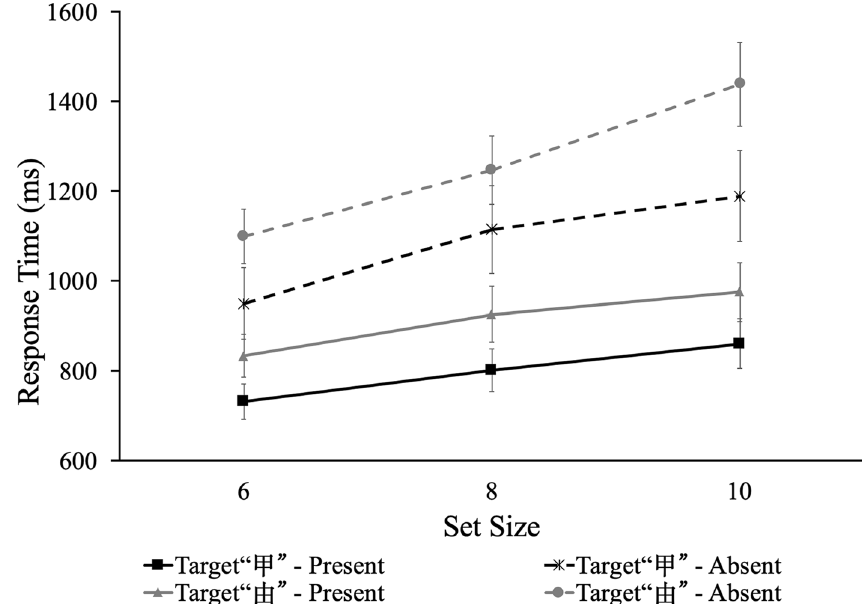
Figure 3. Mean RTs as a function of set size in Experiment 1. Error bars denote the standard